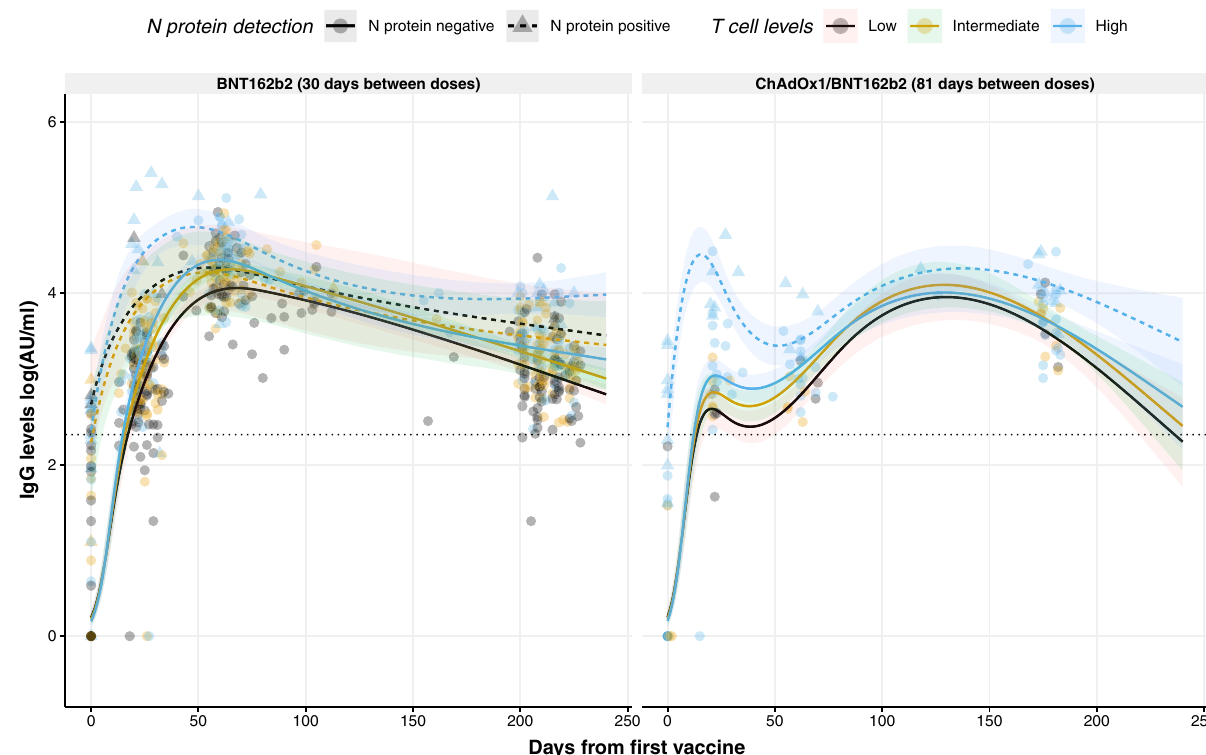
Fig. 5 Circulating IFN- γ levels modeled to circulating IgG levels against RBD in individuals vaccinated against SARS-CoV-2. Distribution of circulating IgG levels, represented in log(AU/ml), over time (days from the fi rst vaccine) in individuals vaccinated with BNT162b2 (left) or with the combination ChAdOx1/BNT162b2 (right). Circles and triangles represent the observed levels of circulating IgG levels for non-previously infected and infected individuals with SARS-CoV-2, respectively. Solid and dashed lines represent the predicted levels of circulating IgG levels for non-previously infected and infected individuals with SARS-CoV-2, respectively. Black, yellow, and blue colors represent low, intermediate, and high levels of IFN- γ released from stimulated T-cells against peptides derived from the S1 subunit of S protein. Black dotted line represents the threshold for assay positivity. Shadowed areas represent the 95% con fi dence interval. Center for the con fi dence interval is the predicted (mean)